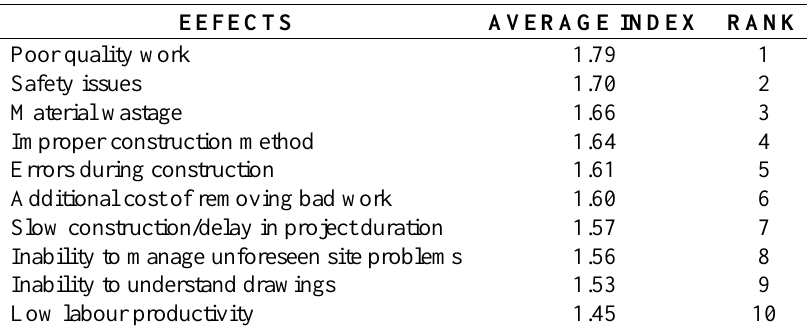
Table 5. Effects of Skilled Labour Shortage